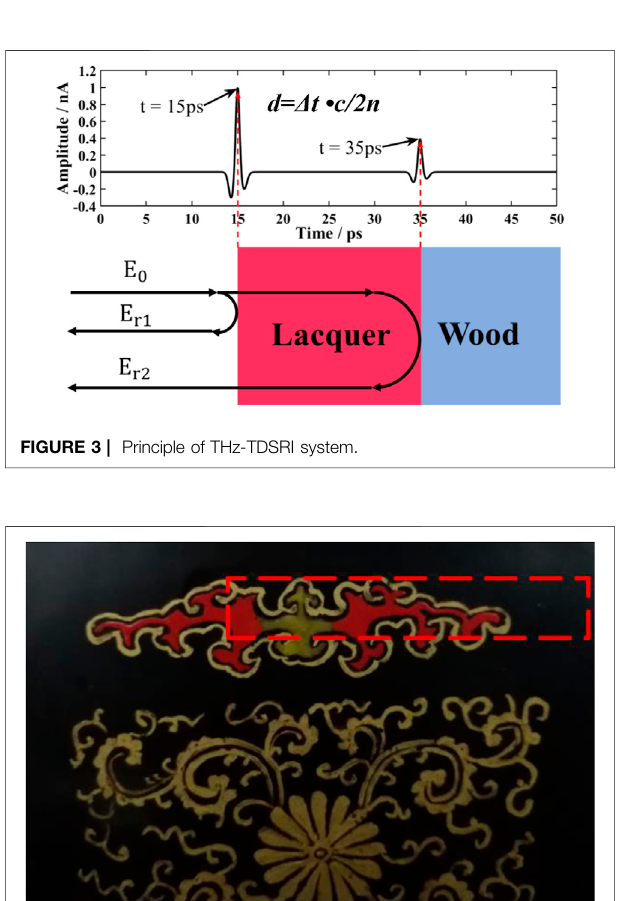
Frontiers in Physics |